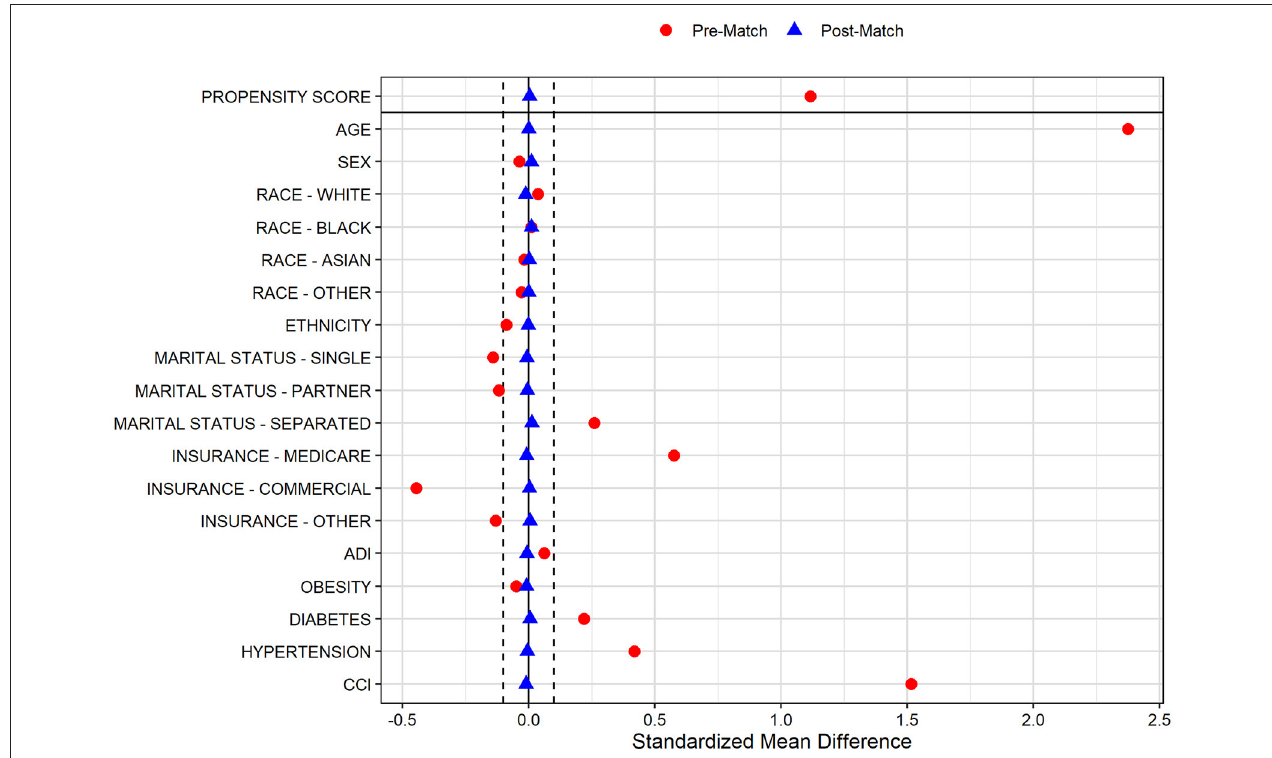
FIGURE 2 | Covariate and propensity score balance for SARS-CoV-2 susceptibility analyses. Pre- and post-matched standardized mean differences (SMD) are presented, using a SMD threshold of 0.1. Cohorts matched on age, sex, race, ethnicity, marital status, insurance coverage, area deprivation index (ADI), obesity, diabetes, hypertension, and overall Charlson Comorbidity Index